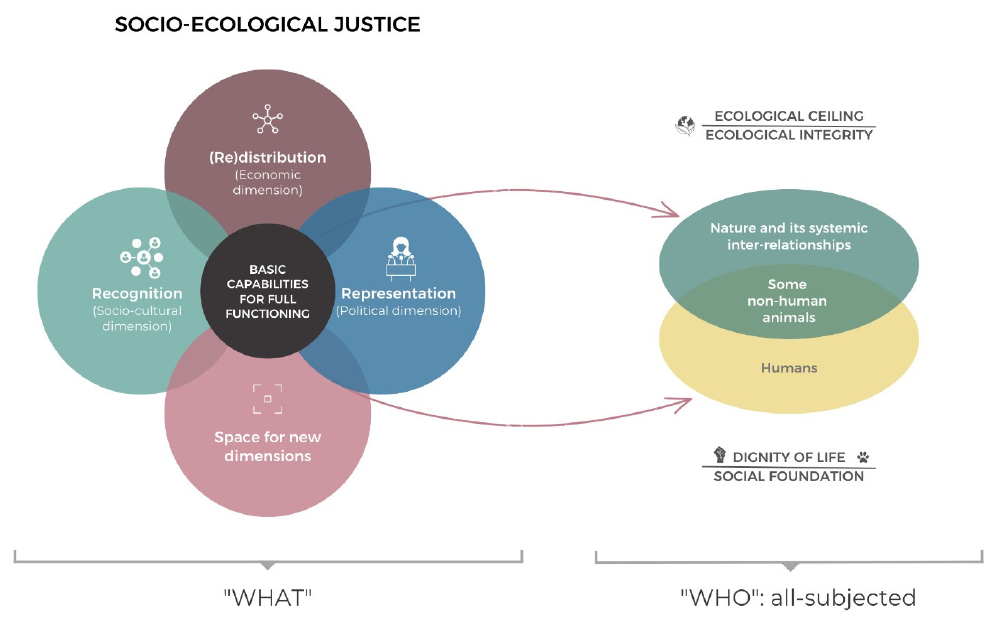
Figure 1. The “what” and “who” of socio-ecological justice (Pope et al.